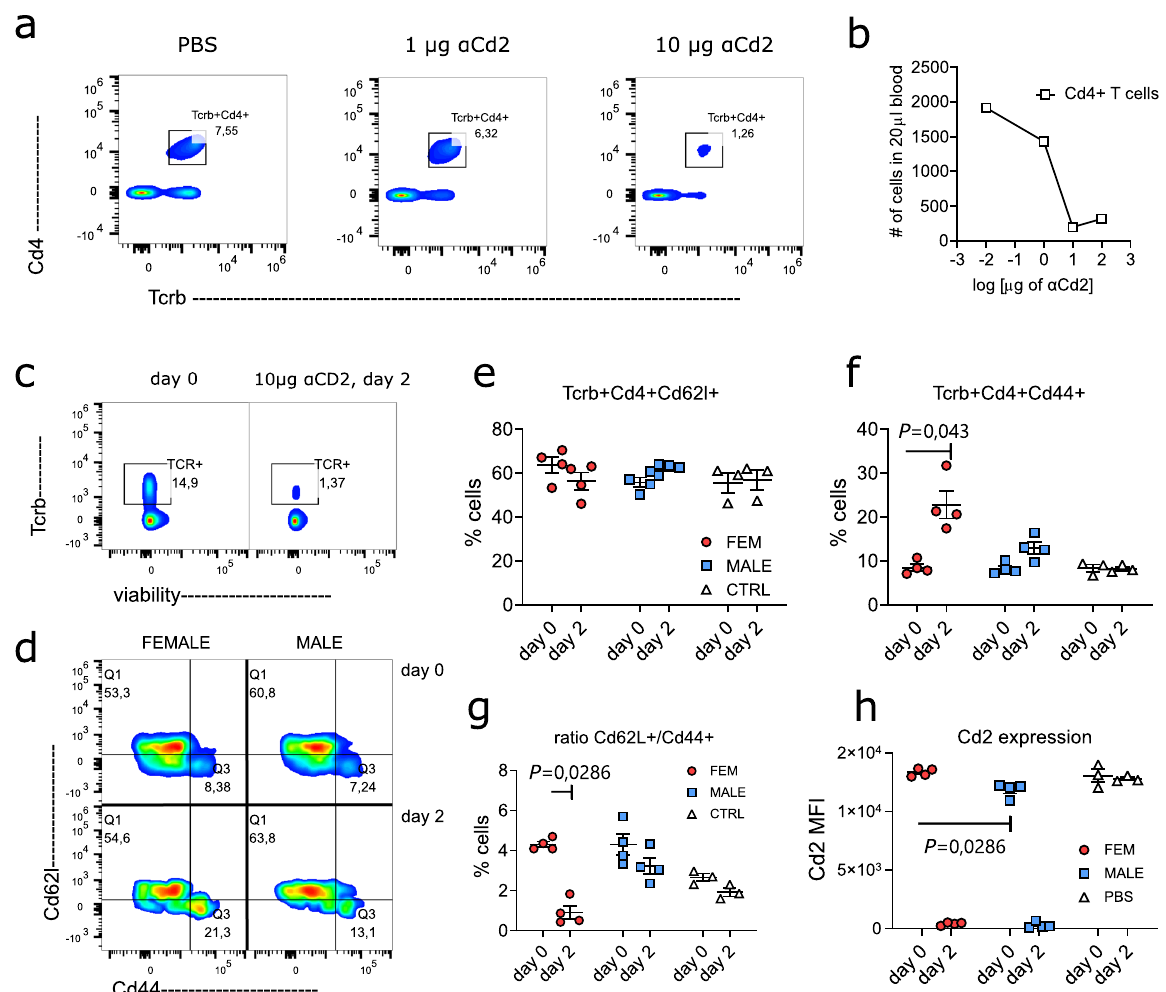
Fig. 8 Anti-Cd2 is more effective at skewing T cell phenotypes in females. a , b Initial titration experiment in mice showing in vivo depletion of T cells in dependency of administered anti-Cd2 mAb RM2-5. Representative fl ow cytometry plots of circulating blood T cells in a and total number of cells in b . Data shown is from one mouse. The experiment was performed three independent times with similar results. c – h Naïve BR male and female mice were injected i.p. with 10 µ g anti-Cd2 mAb RM2-5. Circulating Cd4 + T cells were analysed before (day 0) and after (day 2) mAb injection. Representative fl ow cytometry experiment was performed two independent times with similar results. Individual dots represent independent mouse biological replicates. Data are summarised as mean (SEM). Statistical signi fi cance was evaluated using a two-tailed non-parametric Mann – Whitney U test. Sequential fl ow cytometry gating strategies for a – h are provided in Supplementary fi gs. 17 –